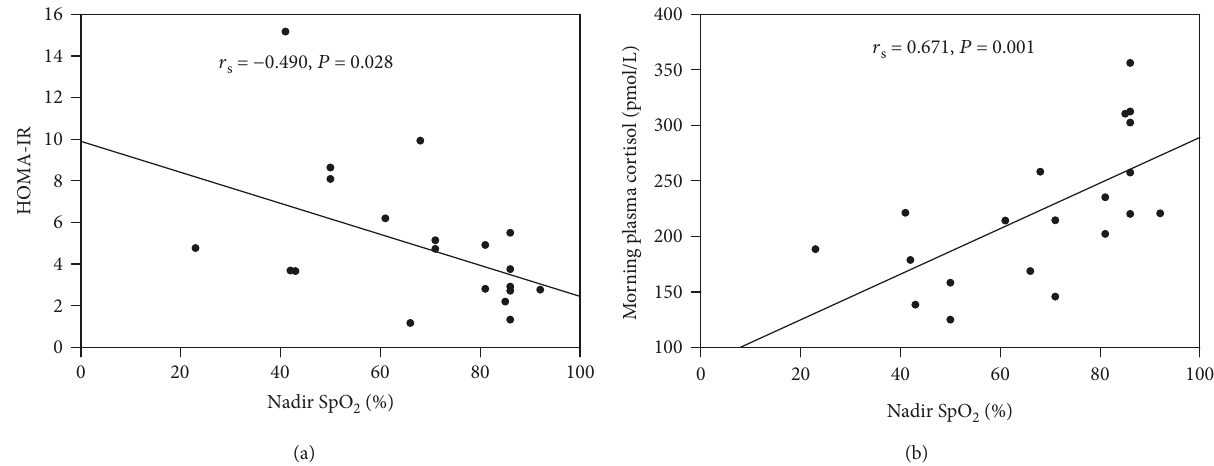
Figure 2: Correlation between nadir SpO2 and HOMA-IR (a) and correlation between nadir SpO2 and morning plasma cortisol (b) of OSA with T2DM patients. HOMA-IR homeostasis model assessment of insulin resistance. AHI: apnea-hypopnea index.